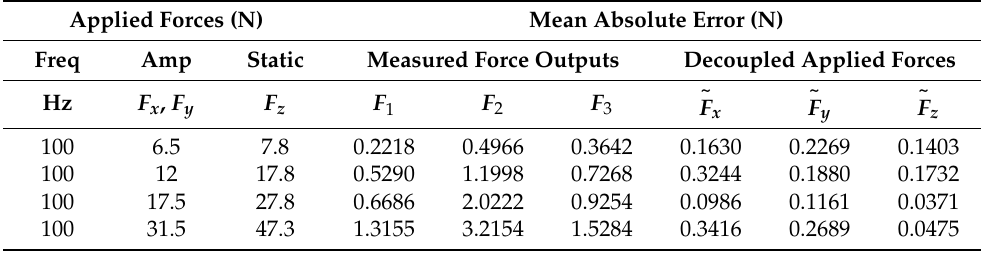
Table 4. Dynamic loading test results due to variation in excitation force amplitudes and static force F z . Applied Forces